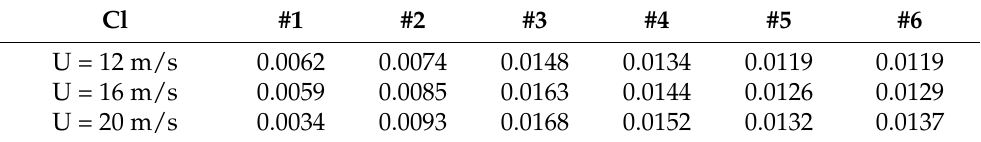
Table 3. Estimated maximum rolling moment coefficient (Cl) for each main